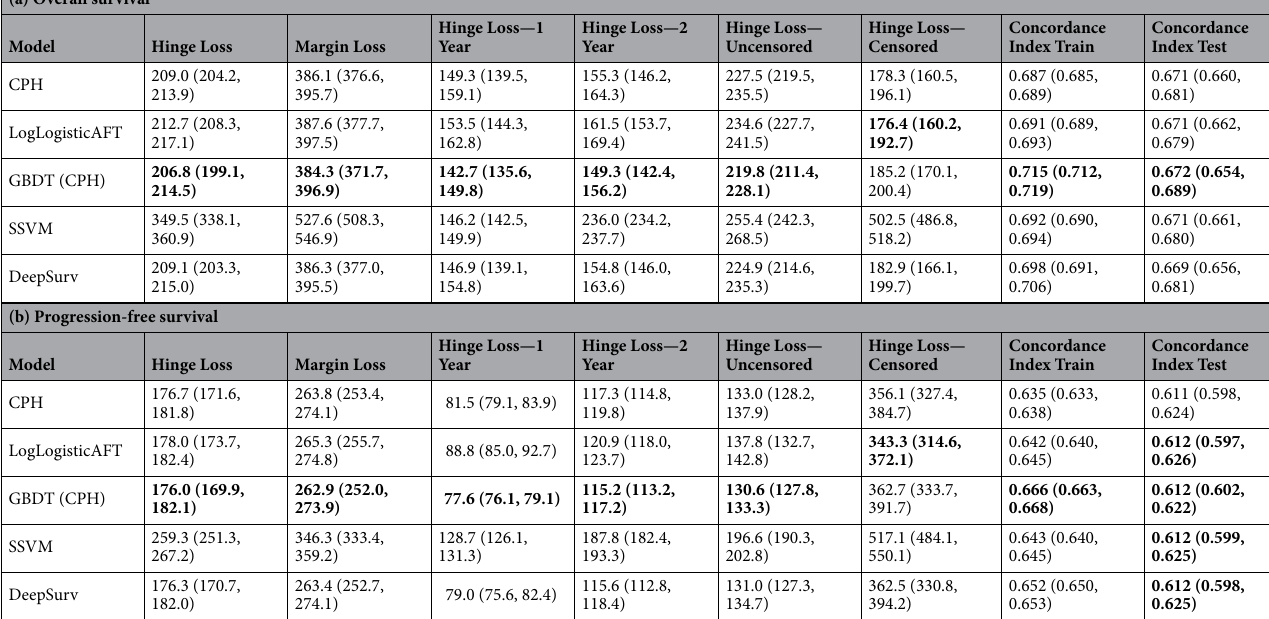
Table 2. Comparison of the models for OS and PFS based on held out validation sets. AFT, accelerated failure time; CPH, Cox proportional hazard; GBDT, gradient-boosted decision tree; SSVM, survival support vector